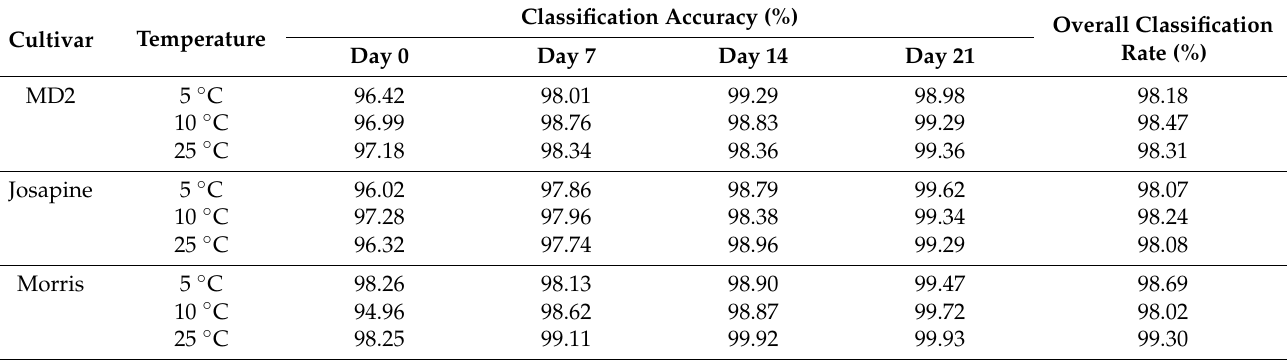
Table 4. Classification performance of pineapple cultivars at different storage days and temperatures using support vector